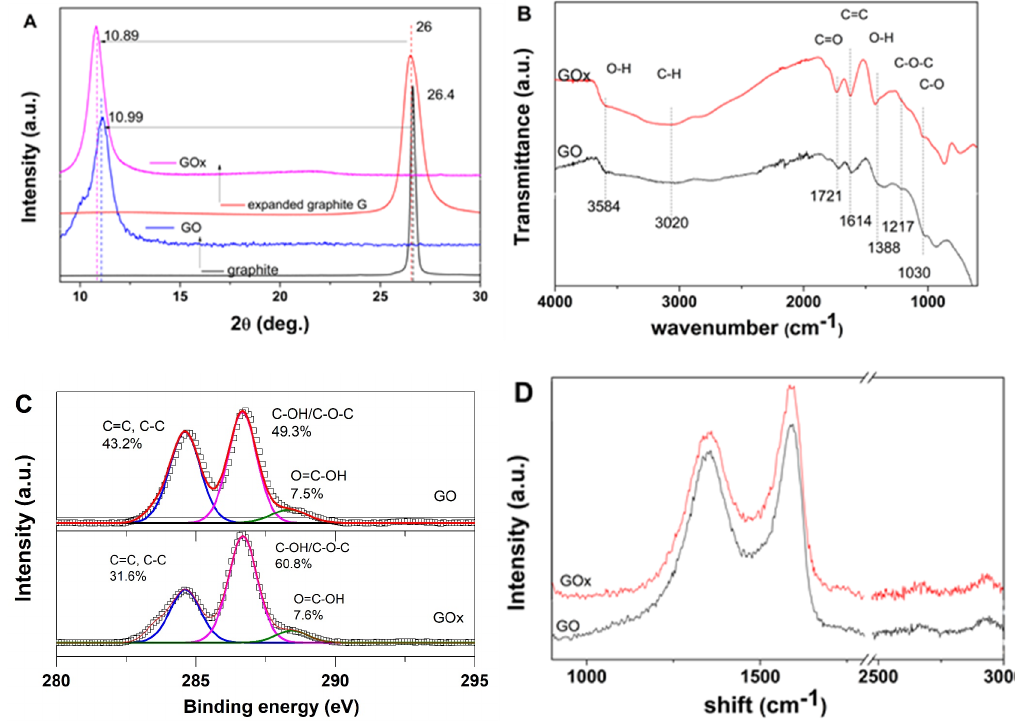
Figure 1. XRD spectra of graphite materials and resulting GOs ( A ), FTIR spectra ( B ), C1s high resolution spectra ( C ) and Raman spectra ( D ) of GO